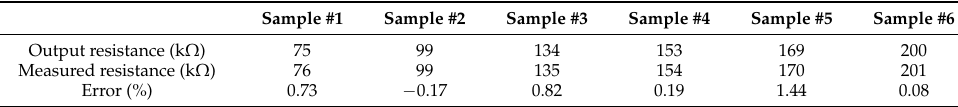
Table 2. The output data of each of the six samples.